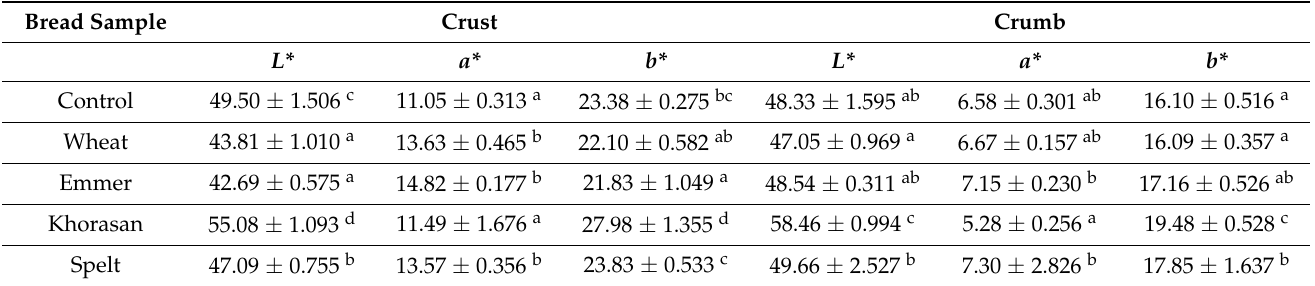
Table 3. Crust and crumb colour of yeast fermented (control) and wheat, emmer, khorasan and spelt sourdough